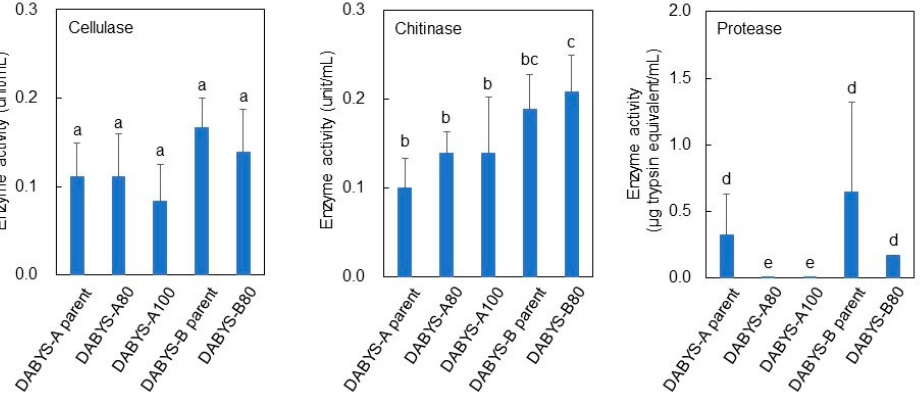
Figure 3. Cellulase, chitinase, and protease activities of DABYS-A80, -A100, and B80. The data are presented as the mean ± standard deviation of independent triplicates. The letters above the columns indicate significant differences at p < 0.05 (Student’s t -test).